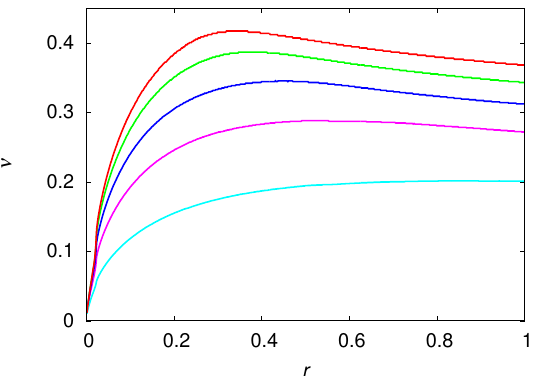
Figure 4. Mean speed of the colonization wavefronts ν as function of the growth rate r for the dispersal probability µ = 0.9 (red line), 0.7 (green line), 0.5 (blue line), 0.3 (magenta line) and 0.1 (cyan